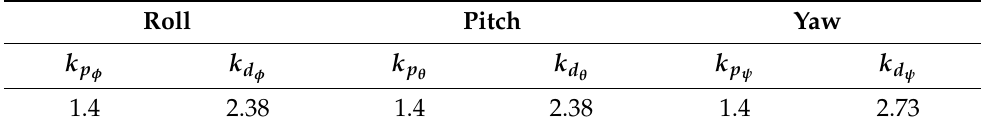
Table 3. Quaternion feedback PD controller’s